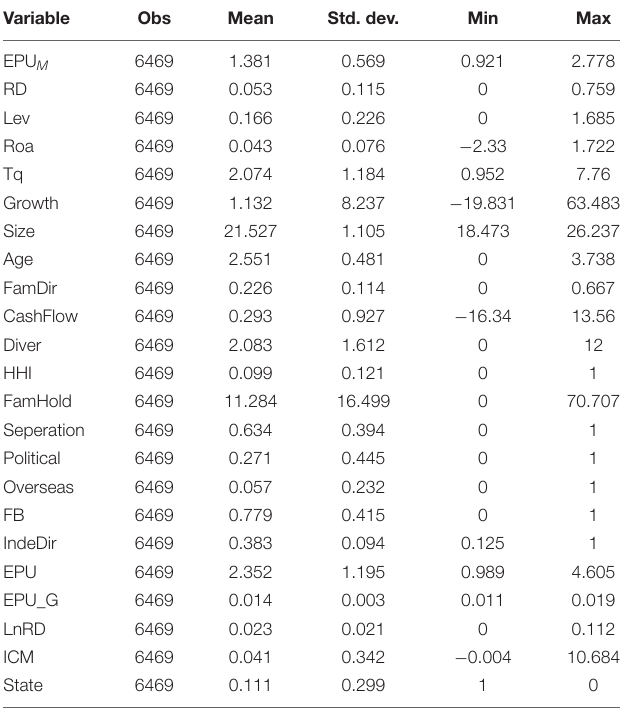
TABLE 1 | Descriptive statistics of